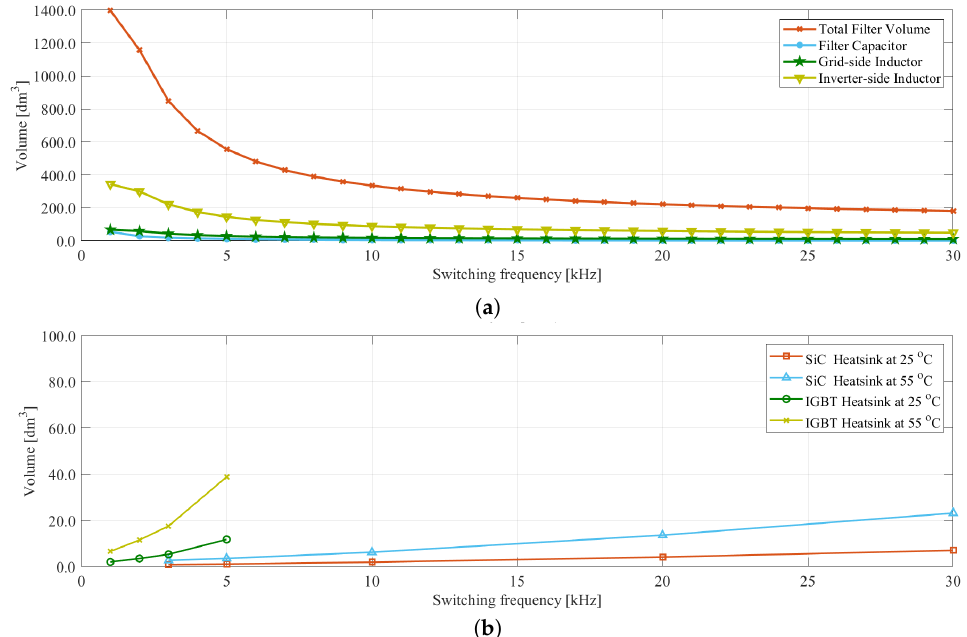
Figure 5. Different passive components volumes for different switching frequencies: ( a ) filter volume, ( b ) heat sink